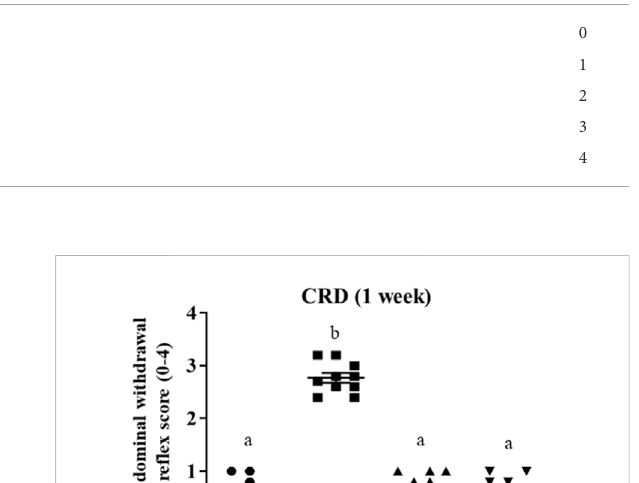
TABLE 2 Abdominal withdrawal re fl ex scores.